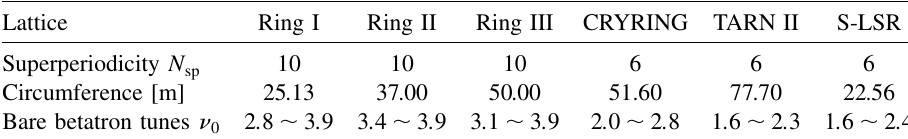
TABLE I. Main lattice parameters of six storage rings considered in Sec. IV.